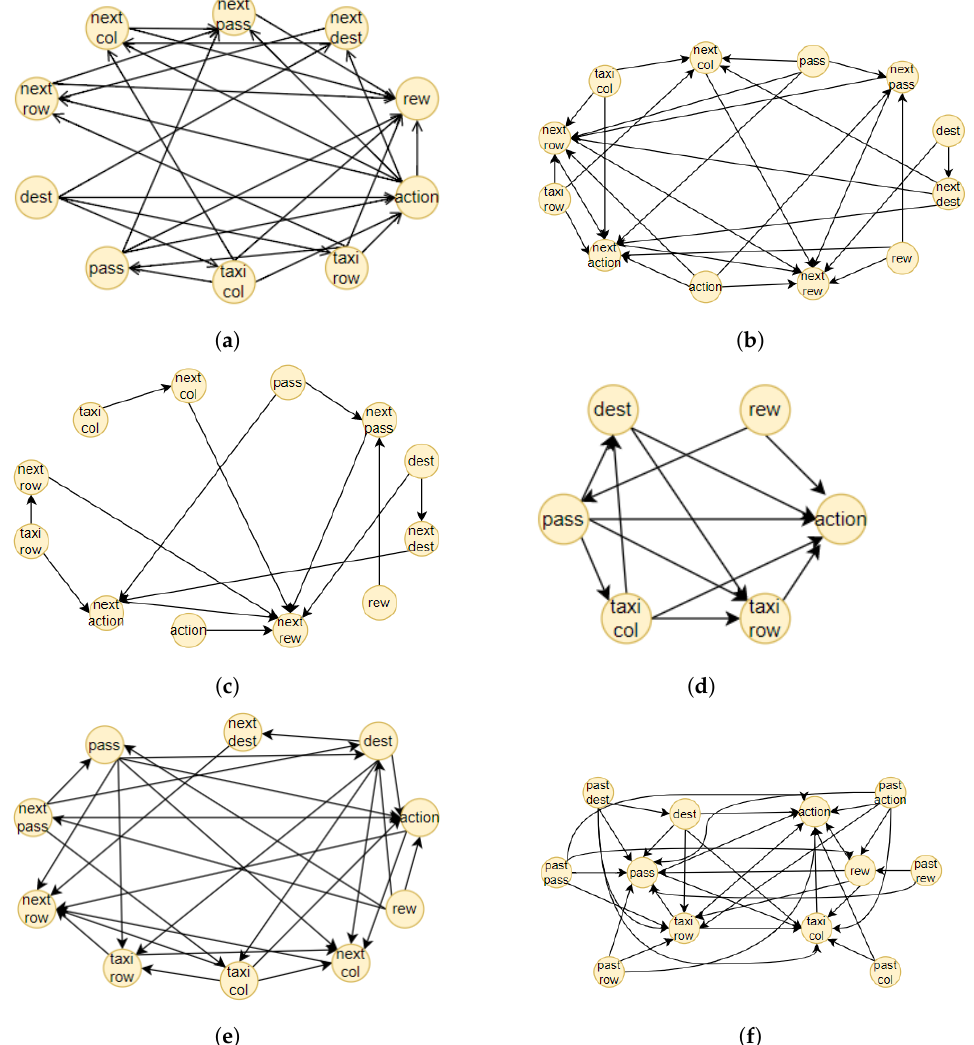
Figure 3. Comparison of causal graphs generated with different algorithms and parameters for Taxi environment. ( a ) BN Graph created by the NOTEARS algorithm with threshold parameter (cid:101) = 0.5. ( b ) DBN Graph created by the DYNOTEARS algorithm with threshold parameter (cid:101) = 0.01. ( c ) DBN created by the DYNOTEARS algorithm with threshold parameter (cid:101) = 0.1. ( d ) Causal graph generated from Direct LiNGAM using only the actual state values. ( e ) Causal graph generated from Direct LiNGAM using both the actual state values and the next ones. ( f ) Causal graph generated from VARLiNGAM with the threshold for the actual relation (cid:101) = 0.01 and for the next time step (cid:101) A =